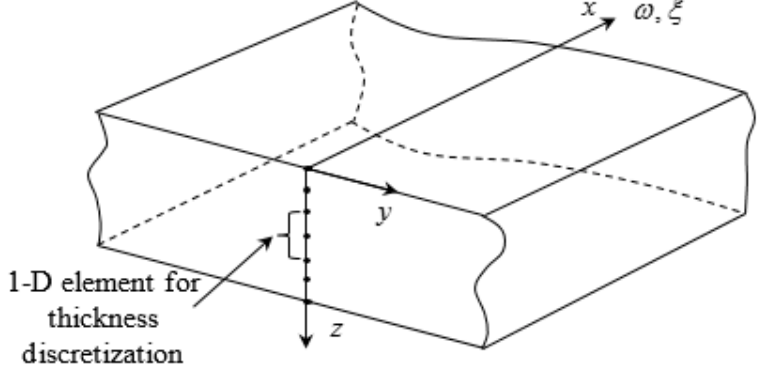
Figure 2. Method for guided wave solution in a plate with arbitrary material properties.